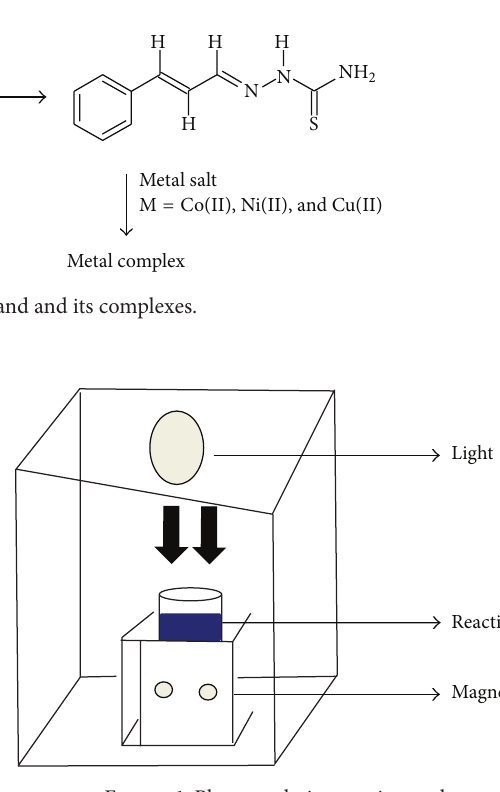
Figure 1: Photocatalytic experimental